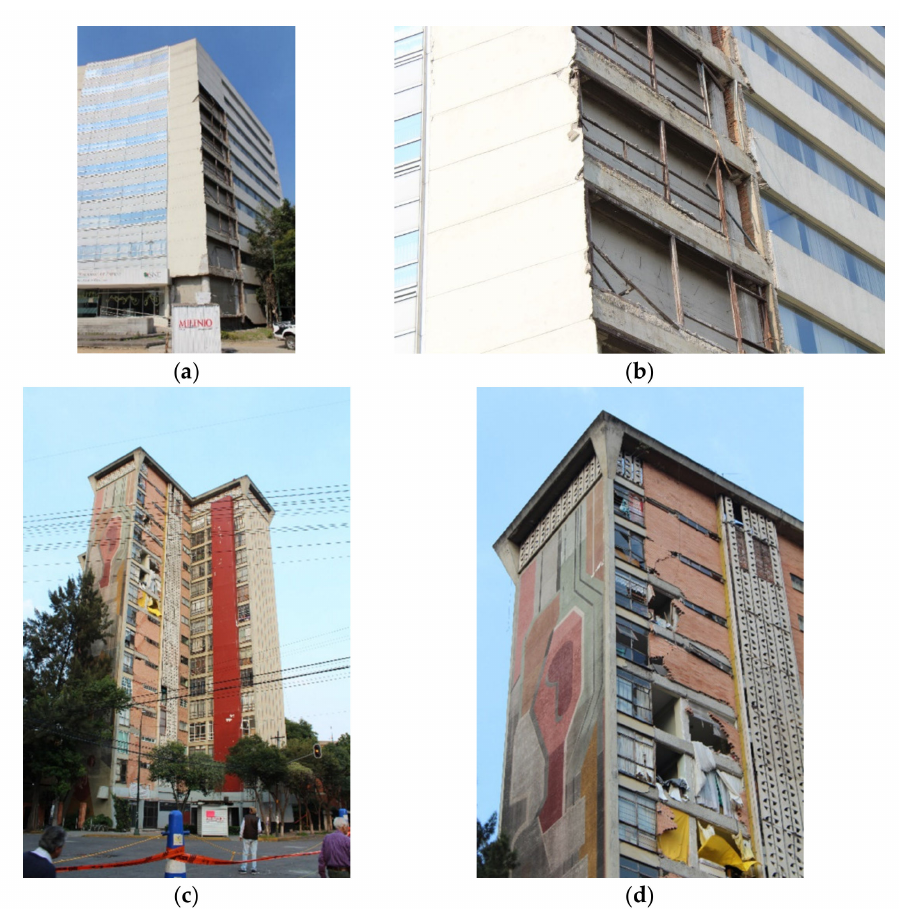
Figure 23. Damage type 10—damage in infill panels: OOP collapse in medium-high RC structures ( a ) Chiapas, Mexico, 2017; ( b ) Chiapas, Mexico, 2017; ( c ) Chiapas, Mexico, 2017 and ( d ) Chiapas, Mexico,